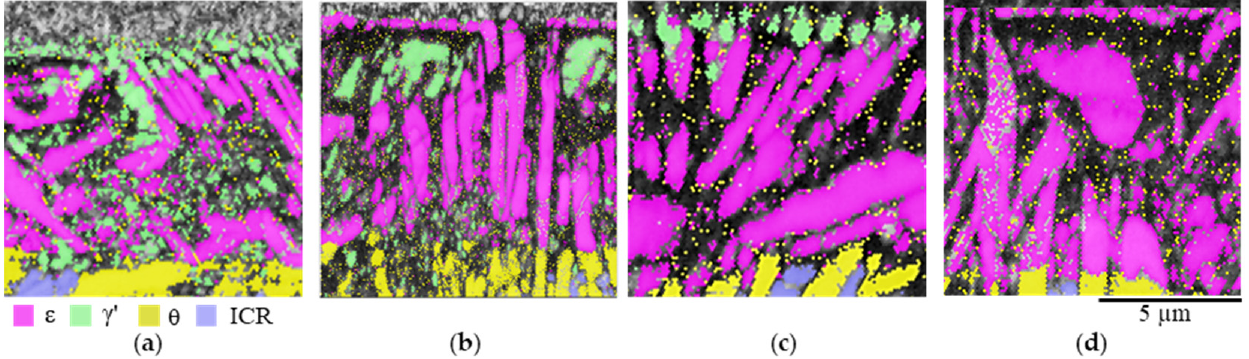
16 h) with ( a , c ) K N = 1 atm − 1/2 and ( b , d ) K N = 4 atm − 1/2 on cast iron alloys: ( a , b ) T-2.2Si-0.1Mn-0.7Cu with Cu, and ( c , d ) T-2.5Si-0.2Mn-0.1Cu with hardly any Cu (individual yellow dots in the com- pound layer: mis-indexed cementite pixels).